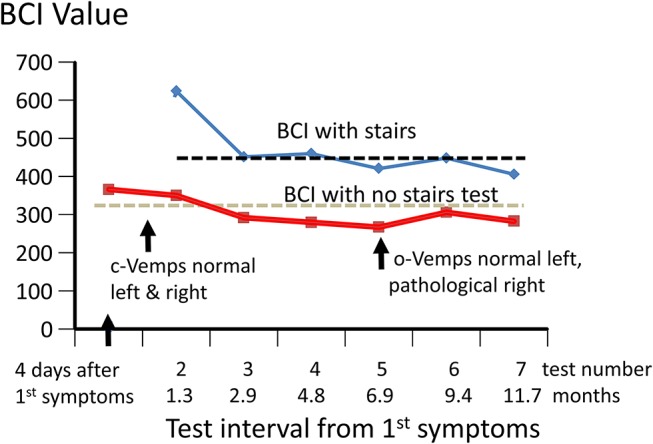
Changes in Balance Control Index (BCI) over 12 months from onset of acute symptoms. The values of the BCI with and without the stairs test included are shown. The stairs test could not be performed for the first test due to the instability of the patient. The upper 95% limit of BCI values (lower values more normal) for the 54 healthy subjects whose ages were within ± 5 years of that of the patient (49 years) are shown by the dashed black and gray lines. The times the c- and o-VEMPs were measured are also indicated.